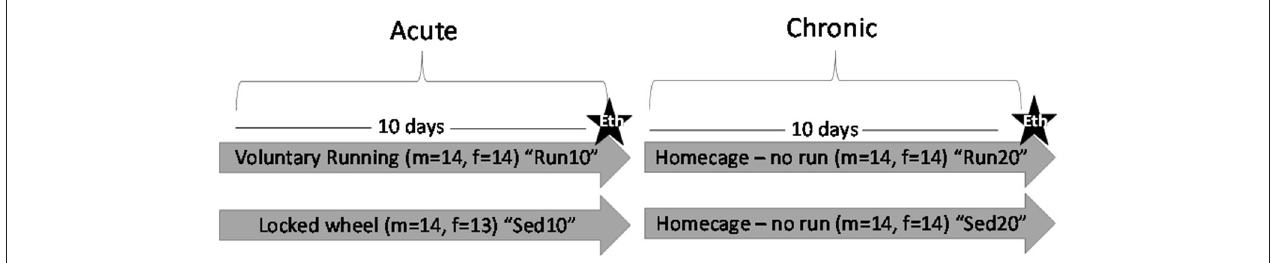
FIGURE 1 | Experiment Outline. Male (m) and female (f) rats were placed in a locked or functional running wheel for 10 days and then euthanized (star) to determine acute effects of exercise. A 2nd cohort of rats were placed in a functional or locked running wheel for 10 days then rested in their homecage for an additional 10 days before euthanasia (star) to determine chronic changes due to exercise. Eth,